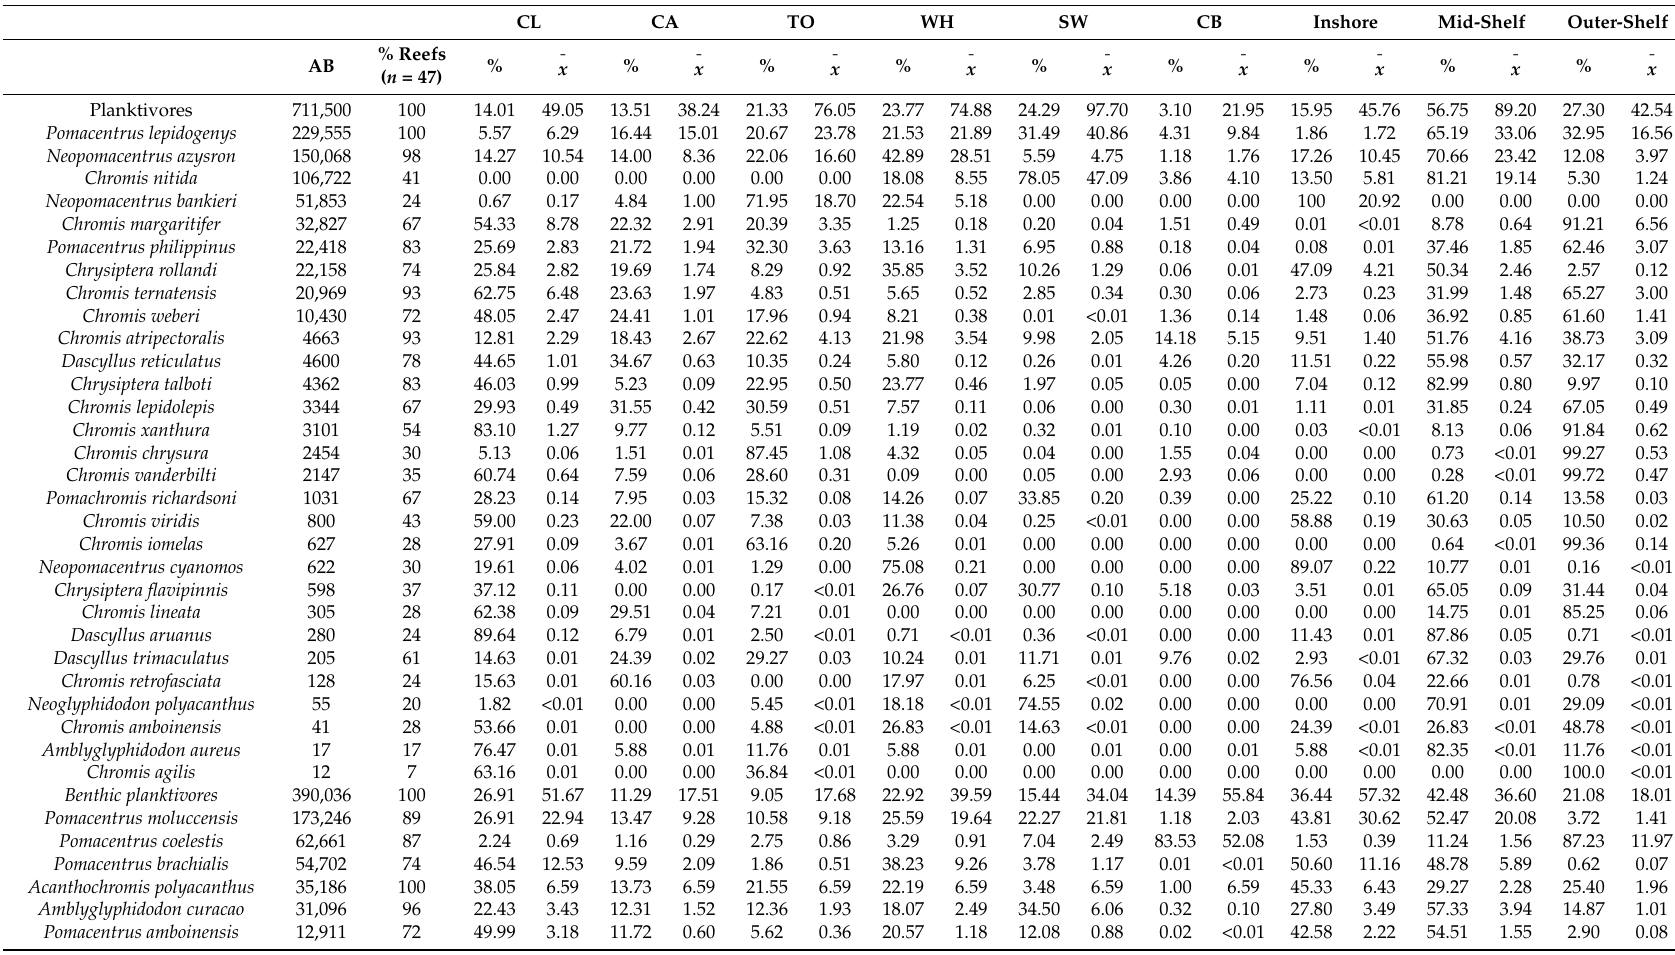
Table 1. GBR planktivorous damselfish species abundance by latitudinal sector and position across the continental shelf. For the sector symbols, CL Cooktown/Lizard Island, CA Cairns, TO Townsville, WH Whitsunday, SW Swain, CB Capricorn-Bunker. Column headings AB = total abundance of species counted throughout surveys; % = distribution of each species as a percentage of total abundance in each sector and shelf; x = average abundance/1000 m 2 for each sector and